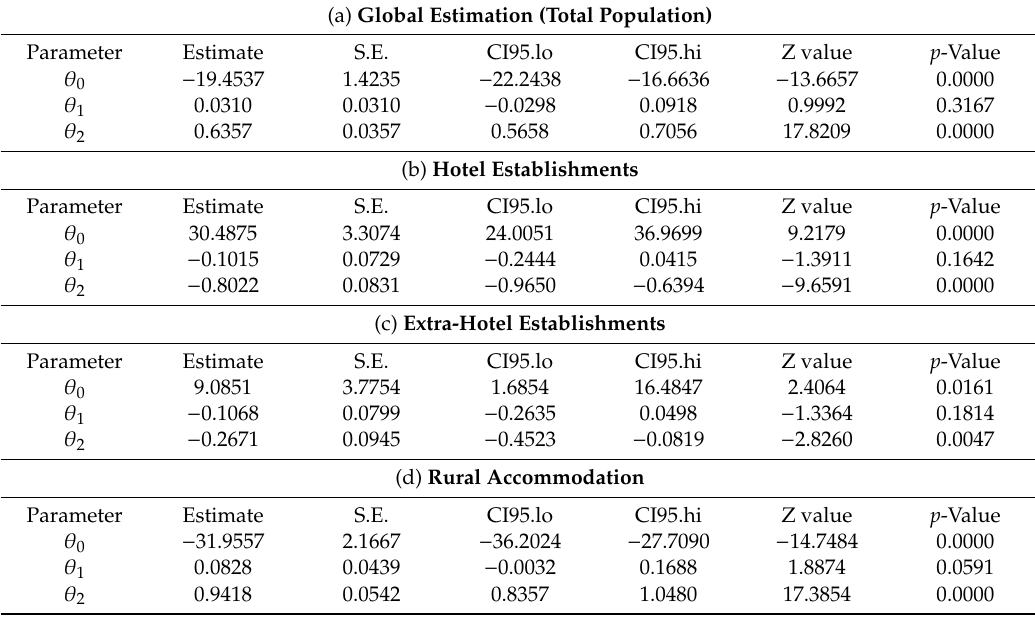
Table 5. Estimation of model (4) λ ( u ,x ) = exp ( θ 0 + θ 1 x + θ 2 y )